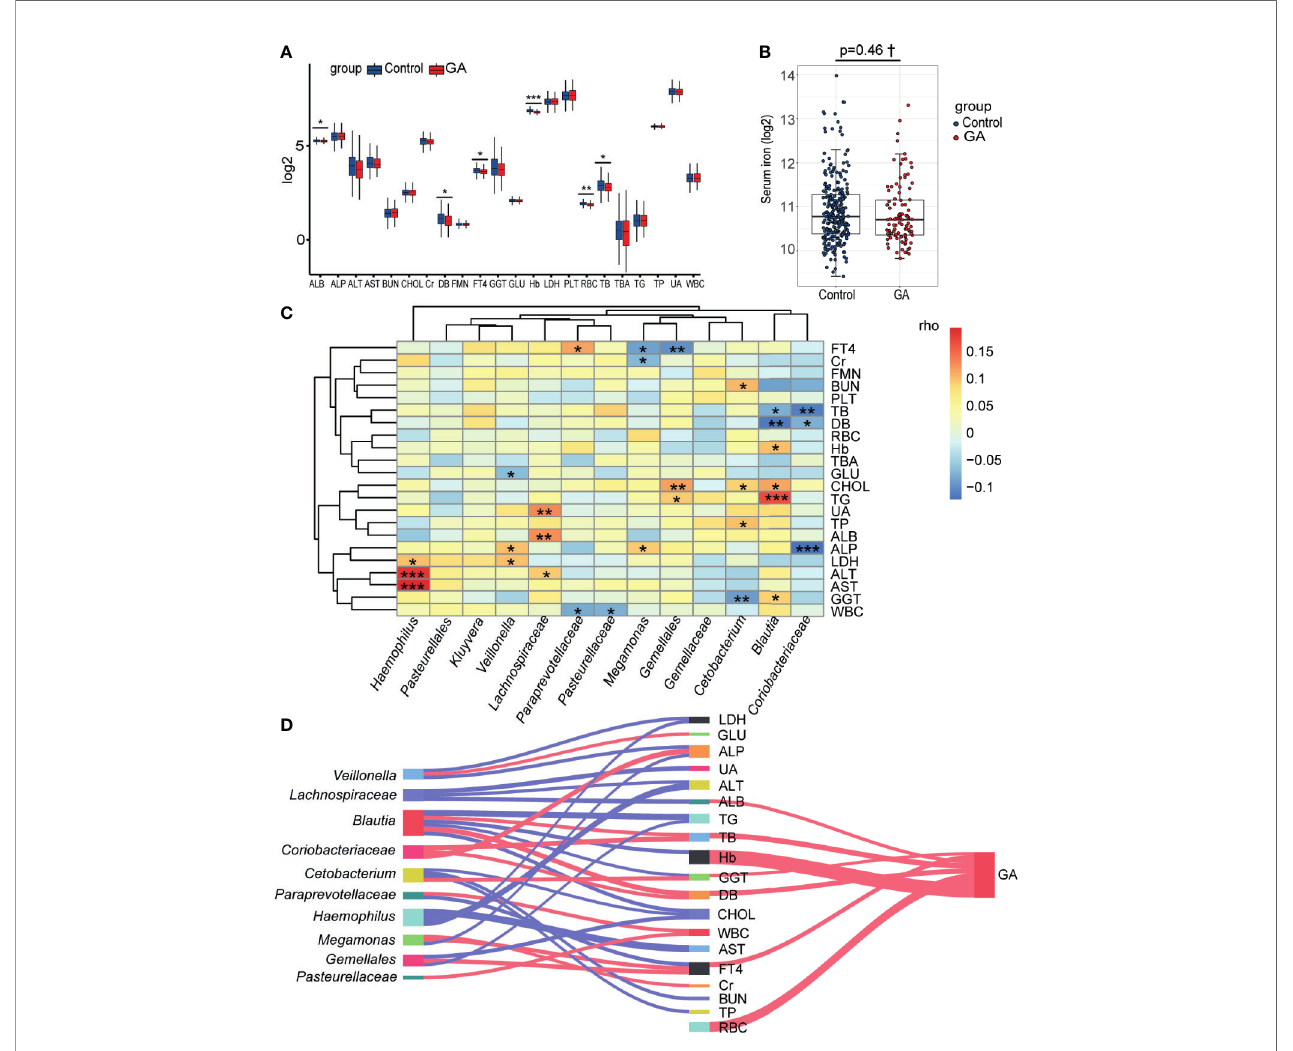
FIGURE 5 | Correlations among the gut microbiota, clinical indices, and GA. (A) The box plot showed that the clinical indices signi fi cantly changed between two groups. (B) The difference of levels of serum iron in the second trimester between the two groups. (C) The heatmap of the partial Spearman correlations between gut microbiota and clinical indices in the second trimester (FDR < 0.05). (D) Relationships among gut microbiota composition, clinical indices, and GA (only signi fi cant correlations were presented, FDR < 0.05). The width of lines represented the partial correlation coef fi cients. Red line represented negative correlation and blue line represented positive correlation. GA, gestational anemia; FDR, false discovery rate; * P < 0.05, ** P < 0.01, *** P < 0.001; † Adjusted for potential